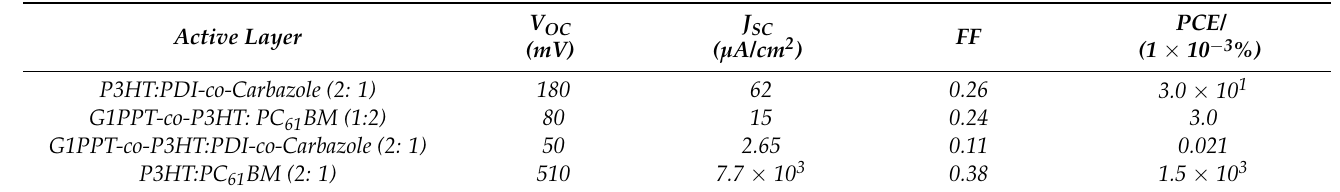
Figure 10. Typical I-V curve characteristic of prepared devices [1]. Table 3. Summary of photovoltaic device performances. Device structure: ITO/PEDOT:PSS/Active layer/Al